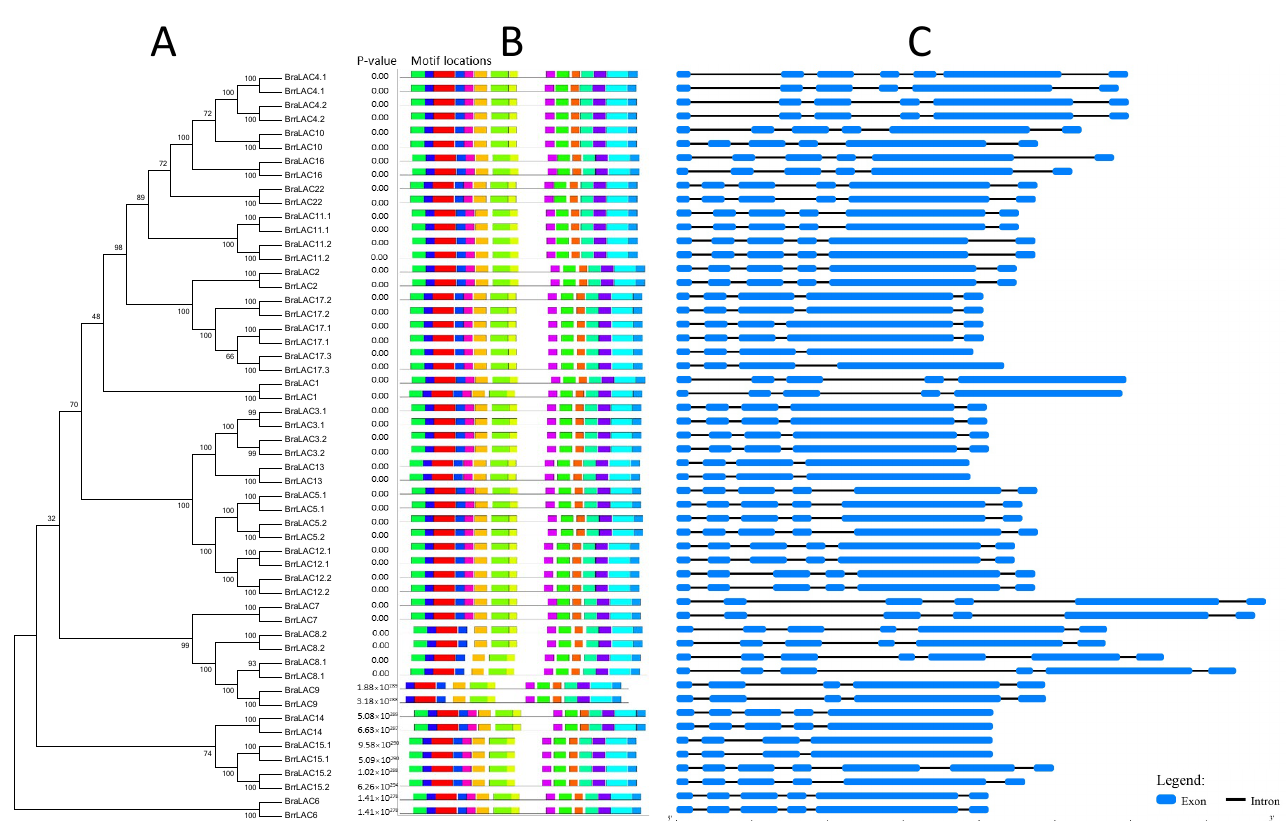
Figure 3. Phylogenetic, conserved motif, and gene architecture analysis of turnip and Chinese cabbage. ( A ) The phylogenetic tree of turnip and Chinese cabbage laccase proteins. ( B ) Conserved motif in laccase proteins. ( C ) Exon–intron architecture of turnip and Chinese cabbage laccase genes. Exons are represented by light blue boxes, and introns are represented with black